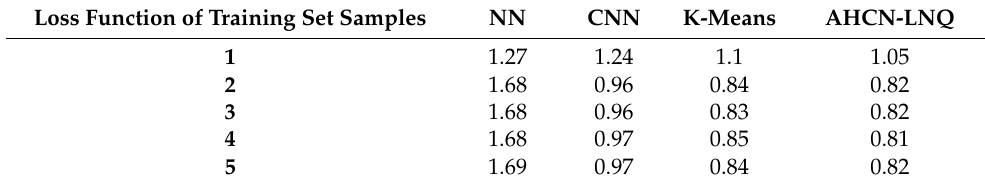
Table 3. Loss function for training set.